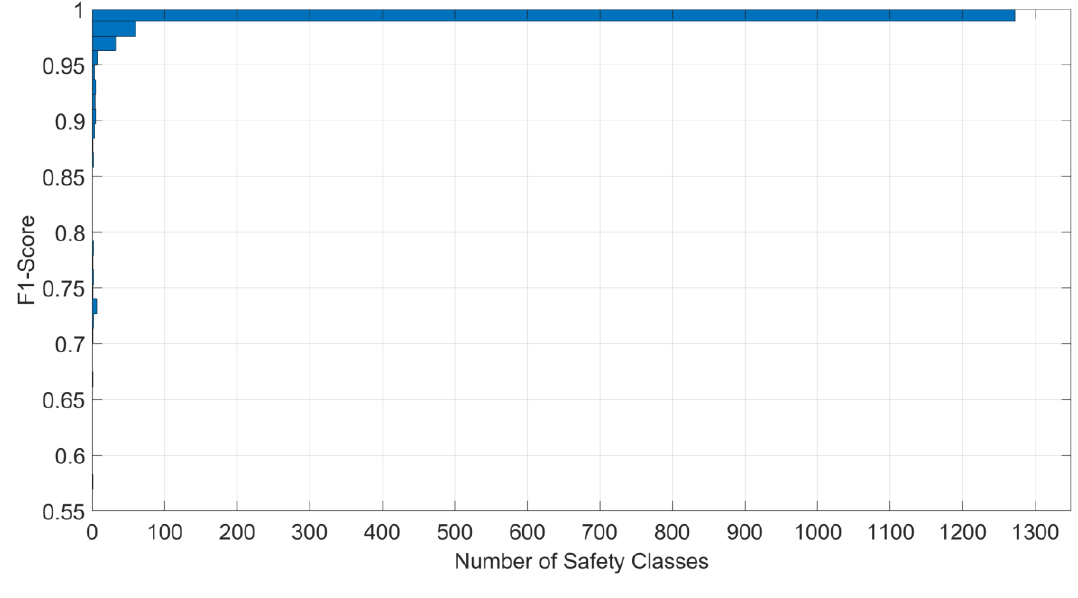
Figure 7. F1 score plot. Table 4. Summary of final classification